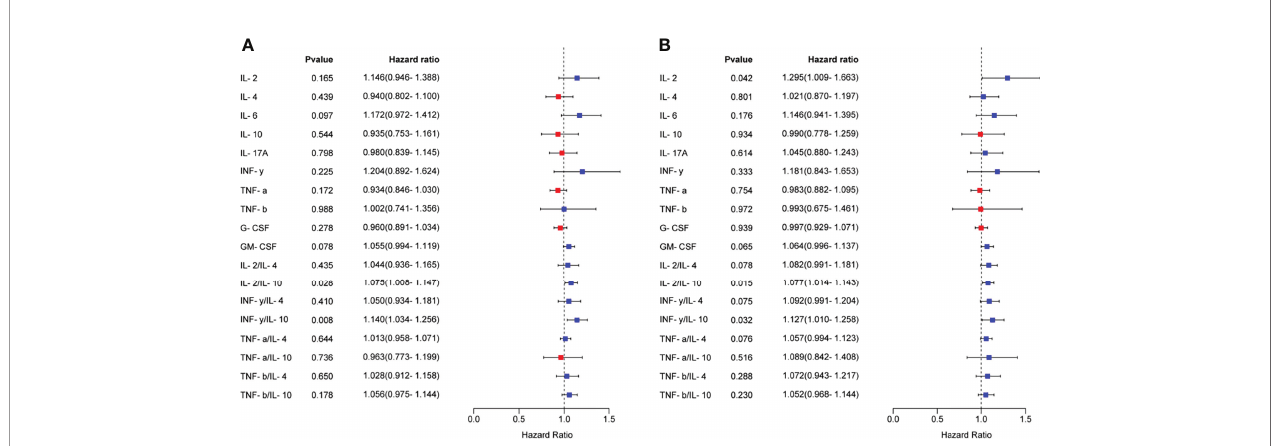
FIGURE 3 | Relationships between serum cytokine pro fi les and the occurrence of RIF. (A) , The relationship between the serum cytokine pro fi les in the mid-luteal phase and the occurrence of RIF was analyzed by univariate logistic regression analysis and visualized as a forest map. (B) , After correcting for maternal age and endometrial thickness on the day of embryo transfer, the relationship between the serum cytokine pro fi les and the occurrence of RIF was analyzed by logistic regression analysis. OR > 1 indicates a risk factor, and OR < 1 indicates a protective